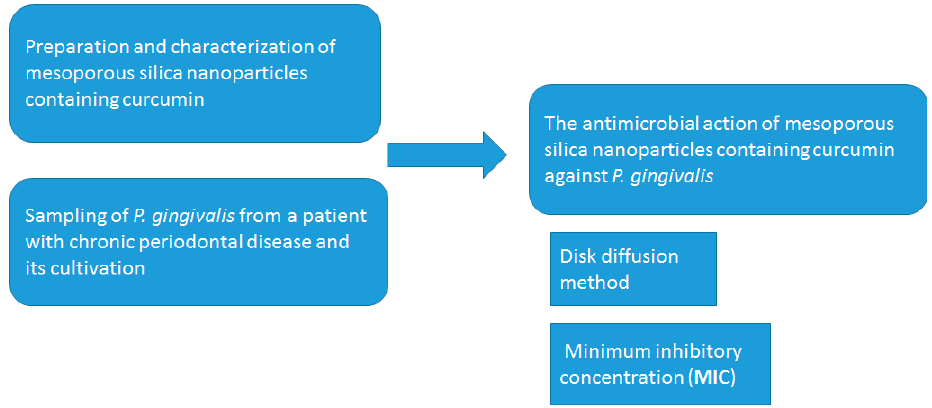
Figure 1. The flow chart of the study process